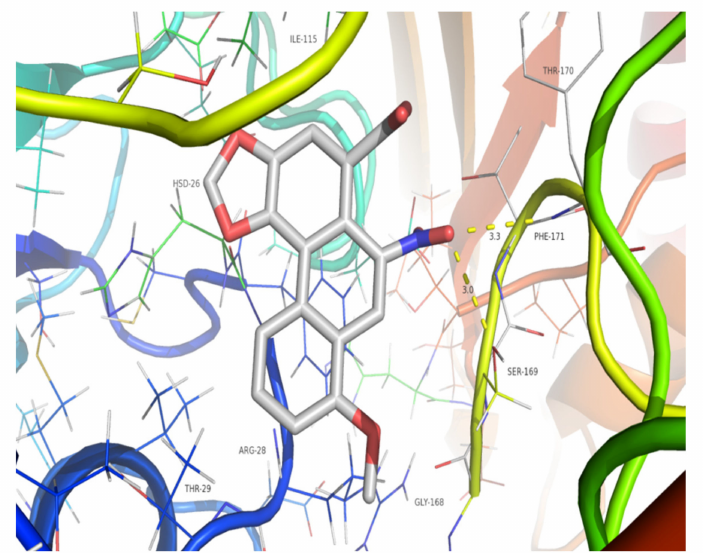
Figure 4. Binding pose of compound 3 docked into the protein 4NOG. The yellow dotted lines indicate hydrogen bonds between compound 3 and 4NOG.